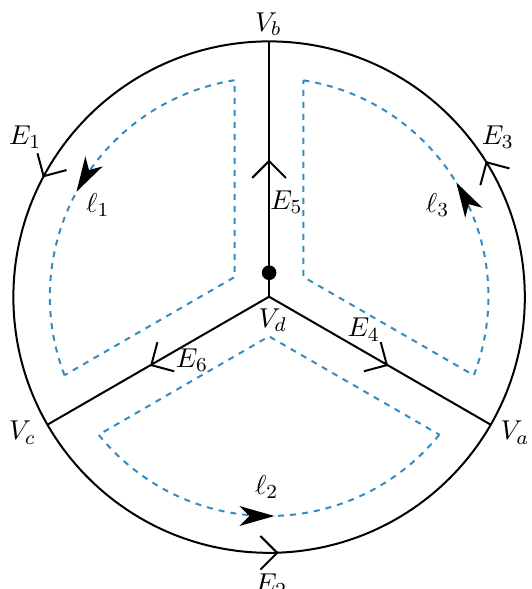
Figure 23. The symmetric g = 3, n = 0 tetrahedral